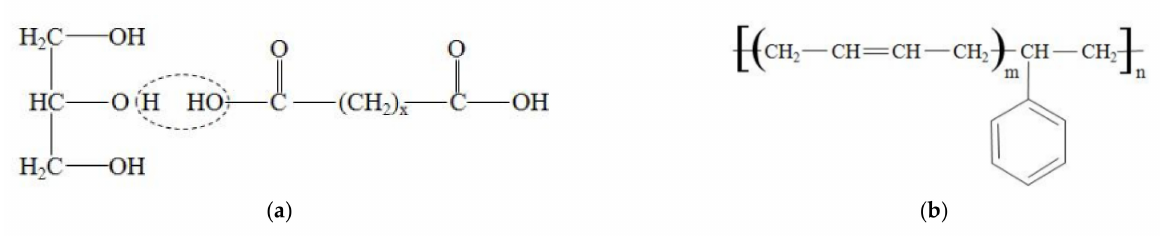
Figure 1. Rational formulae of ( a ) thermoset polyester, and ( b ) styrene